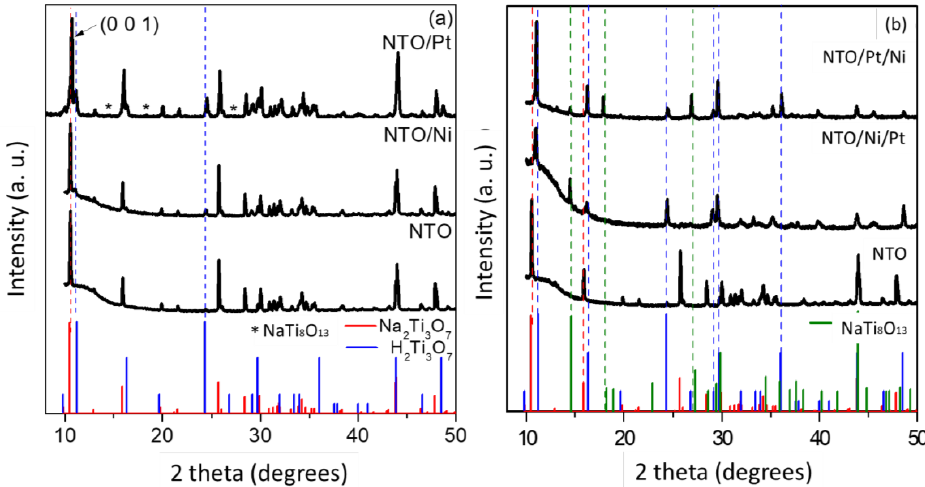
Figure 1. XRD patterns of Na 2 Ti 3 O 7 pure and loaded with Ni and Pt ( a ), and NTO/Ni/Pt and NTO/Pt/Ni ( b ).